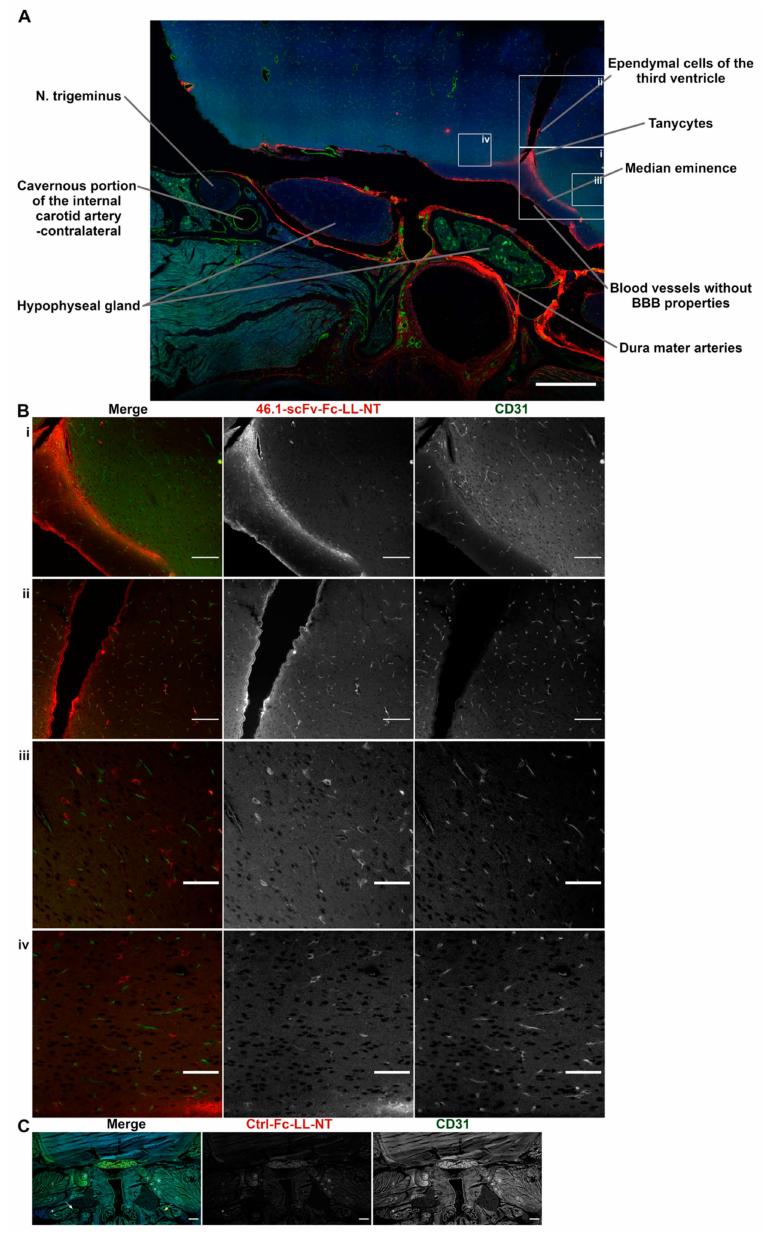
Figure A1. Detailed localization of 46.1-scFv-Fc-LL-NT in the cavernous sinus and brain. ( A ) Overview at low magnification of the distribution of 46.1-scFv-Fc-LL-NT (red) and CD31 (green) in the head and brain, as described in Figure 4. Scale bar, 500 µ m. ( B ) Boxed areas from ( A ) ( i ) 46.1- scFv-Fc-LL-NT (red) is localized at the floor of the median eminence, tanycytes, cell bodies, and emanating projections of ME parenchymal cells. Scale bar, 100 µ m. ( ii ) Hypothalamic microvascu- lature and ependymal cells of the third ventricle show immunoreactivity for 46.1-scFv-Fc-LL-NT. Scale bar, 100 µ m. ( iii , iv ) Ipsilateral and contralateral hypothalamic non-vascular cells are labeled for 46.1-scFv-Fc-LL-NT. Scale bar, 50 µ m. ( C ) Control antibody (red) is not detected in the head and brain. White and yellow arrows represent the cavernous portion of the internal carotid artery, contralateral, and ipsilateral, respectively. Scale bar, 500 µ